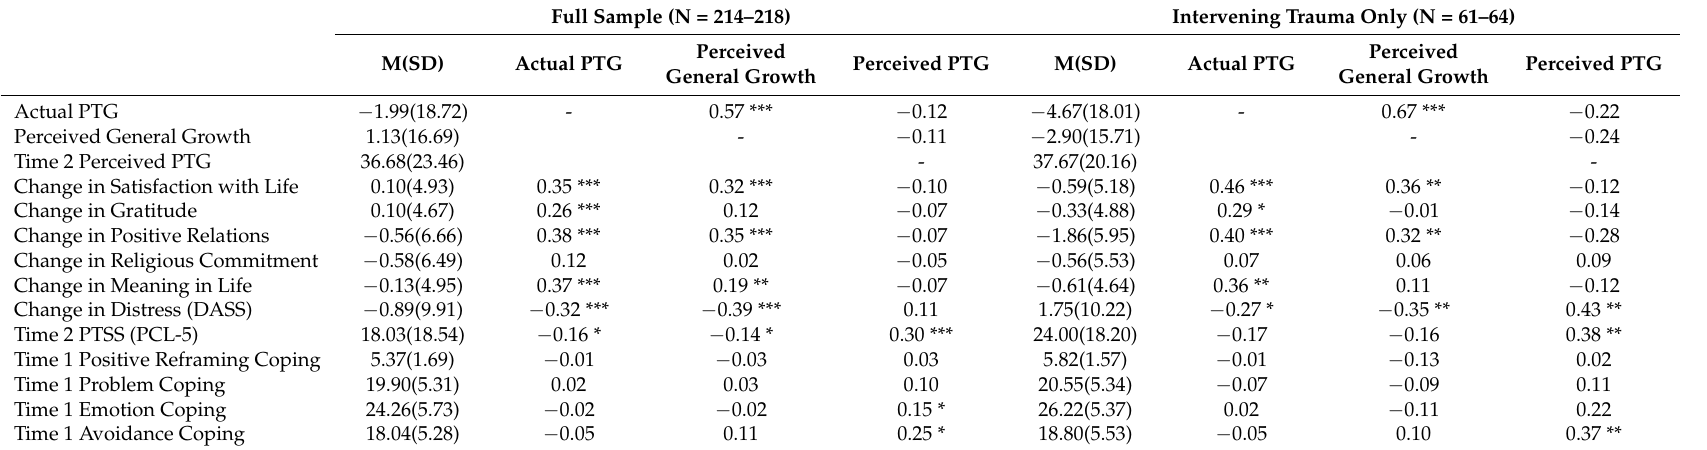
Table 4. Correlations between actual change, perceived general change, and perceived PTG scores and changes in PTG-domains, distress, and coping in the full sample and trauma sample